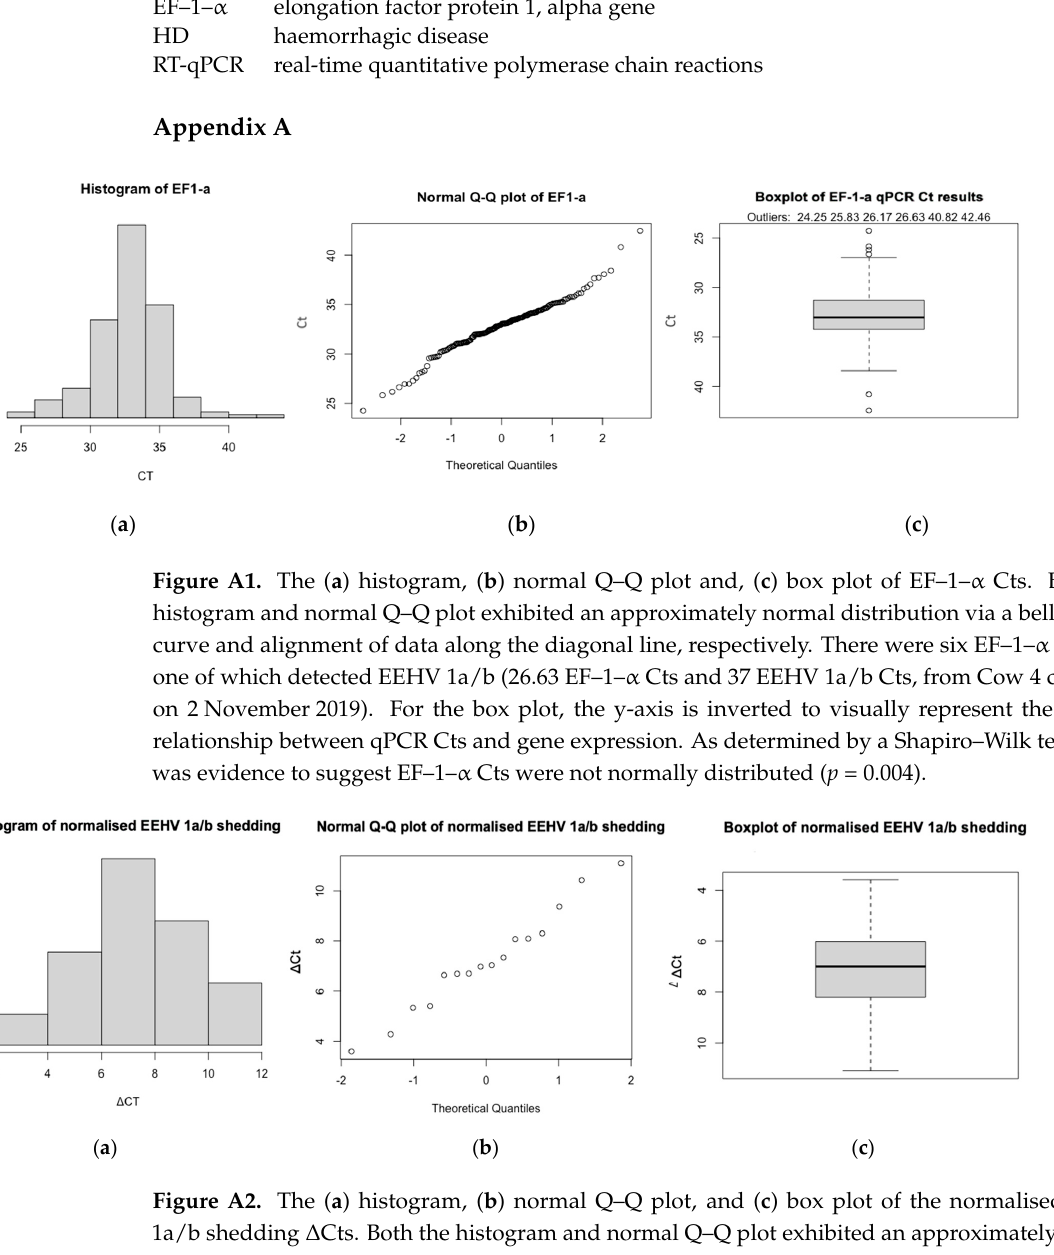
( a ) ( b ) Figure A3. The ( a ) histogram and ( b ) normal Q–Q plot of GEE residuals, informed by normalised shedding ( Δ Ct) and social change management periods. Histograms and normal Q–Q plots for social change, between and within herd moves, were all identical as they incorporated the same data set. The histogram and Q–Q plot exhibited an approximately normal distribution via a bell- shaped curve and alignment of data along the diagonal line, respectively. There was no evidence to suggest the distributions were not normal as determined by a Shapiro–Wilk test (social change p = 0.8, between herd moves p = 0.8, within herd moves p = 0.8). References 1.